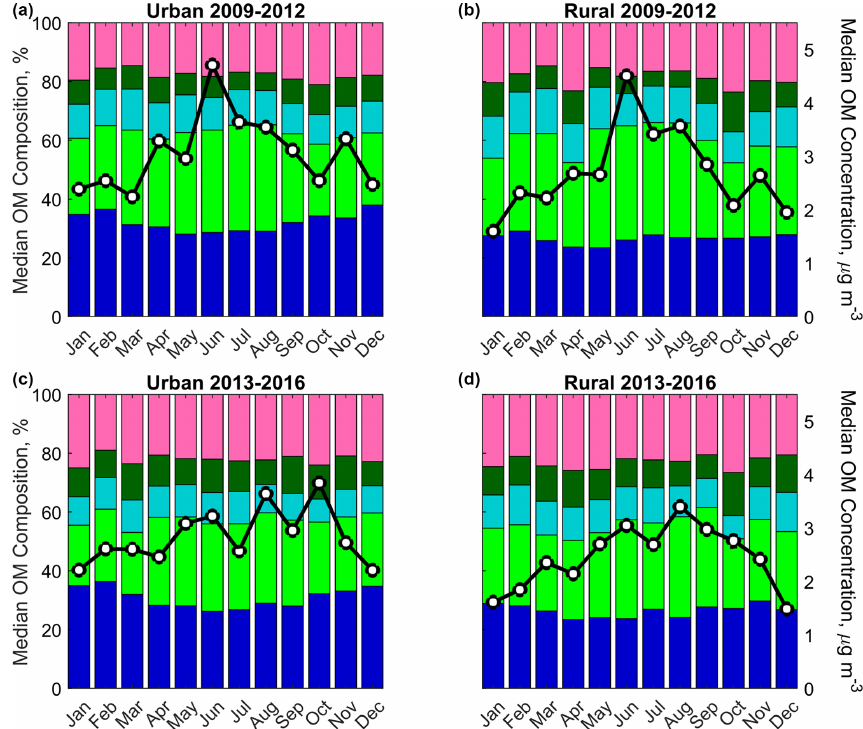
Figure 6. Monthly FG composition and OM concentration during 2009–2012 (a, b) and 2013–2016 (c, d) and urban (a, c) and rural (b, d) subcategories. Stacked color bars represent the monthly median FG contributions to OM concentration (see Fig. 3 for FG legend), while black lines with white markers represent the monthly median OM